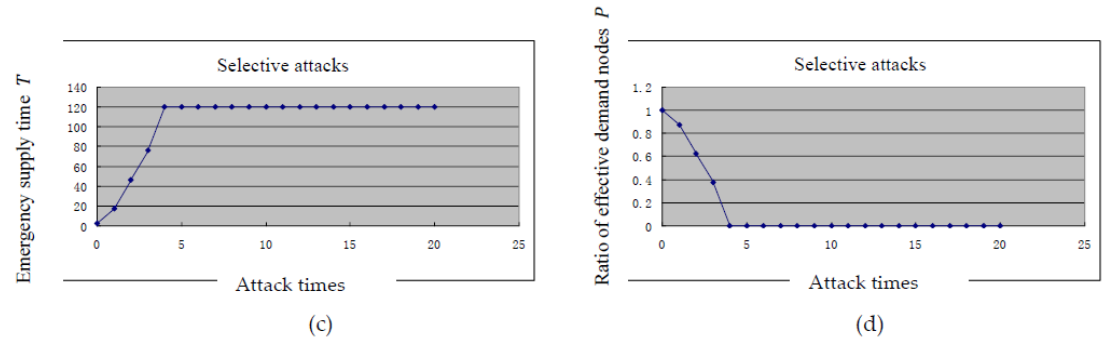
Figure 4. Simulation results under two modes of attack.